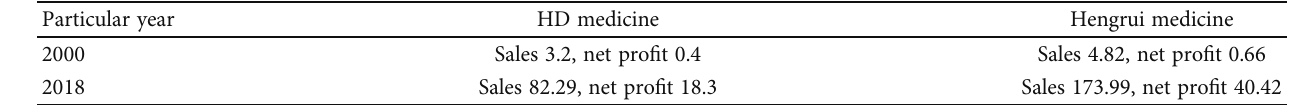
Table 6: Comparison of fi nancial data.